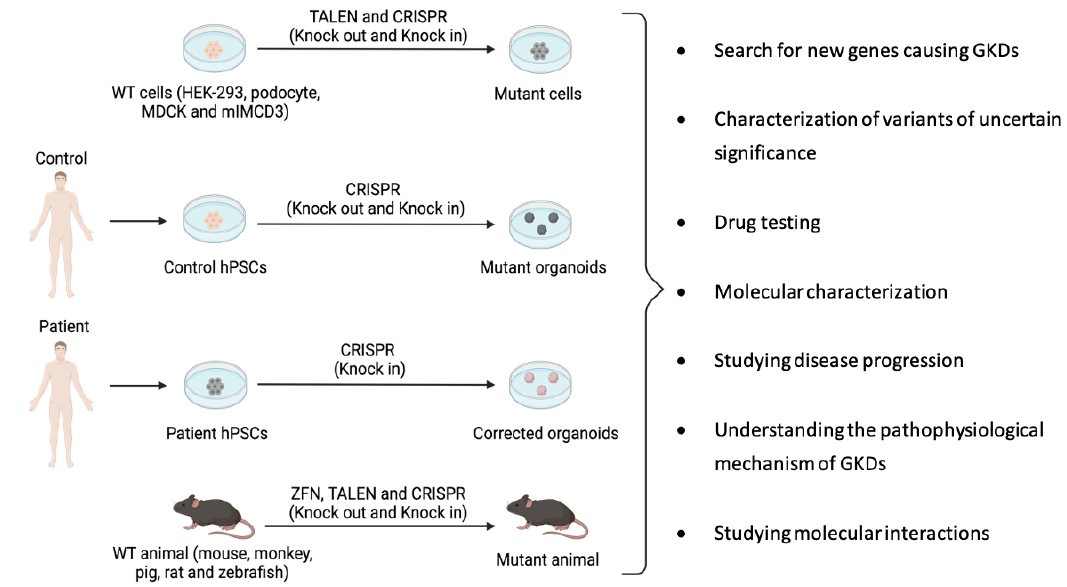
Figure 4. Workflow for disease modeling using genome editing technologies in different models. The different gene editing tools used in each of the possible models (cells, organoids, or animals) are represented, indicating their implication in the study of GKDs.